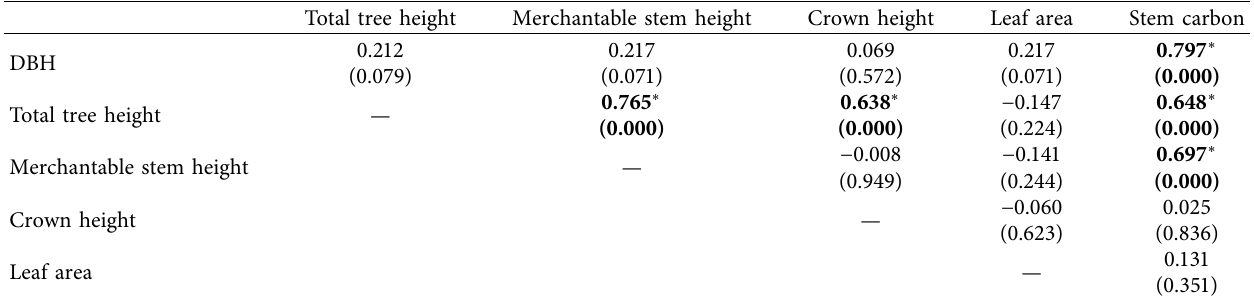
Table 3: The correlation coefficient of Pearson’s correlation analysis among the tree parameters of Rhizophora mucronata .